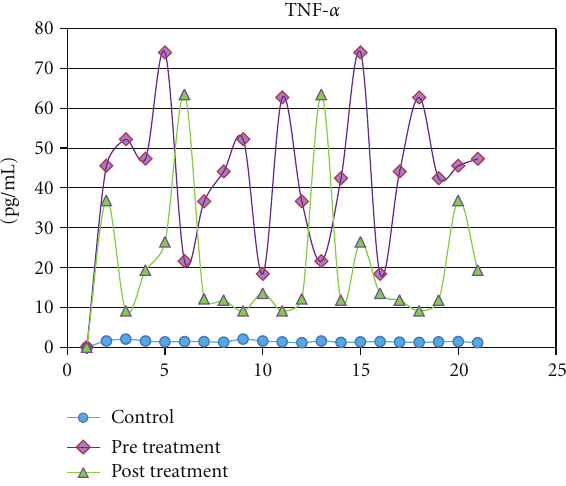
Figure 2: Salivary levels of TNF- α measured in pg/mL from control subjects compared with levels in ELP patients before and after treatment with